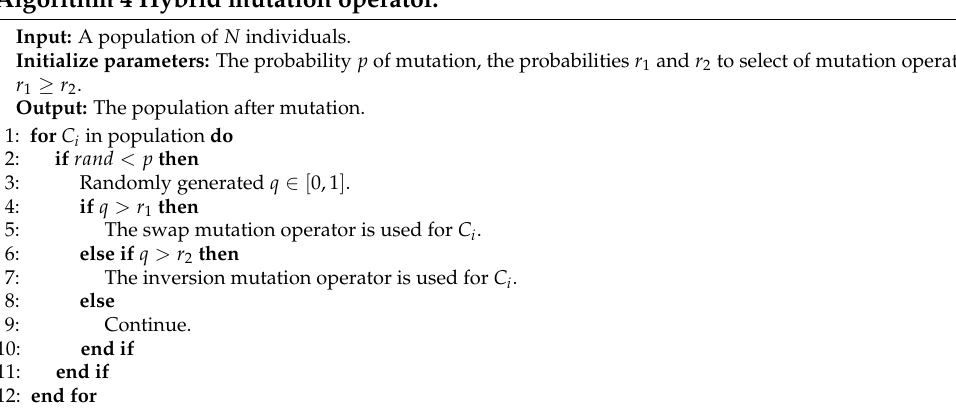
Algorithm 4 Hybrid mutation